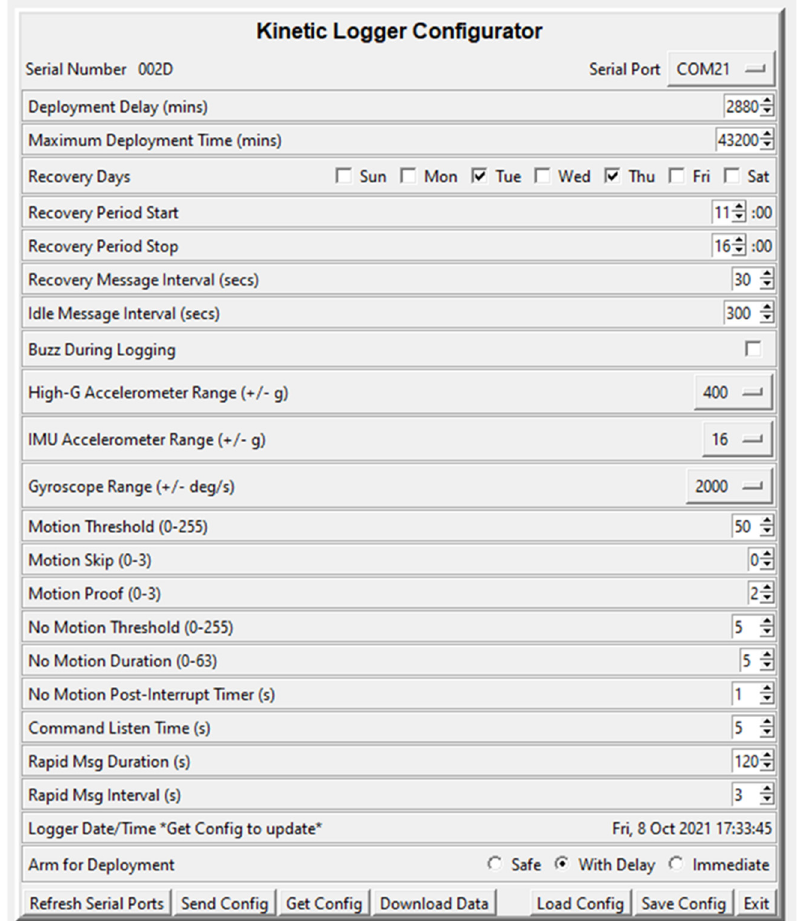
Figure 2. Kinematic Logger Configurator python application for setting deployment parameters, sending configuration, updating real time clock, and downloading data. Table 1. Kinematic Logger modes and functions with CPU frequency, average current, and cur- rent